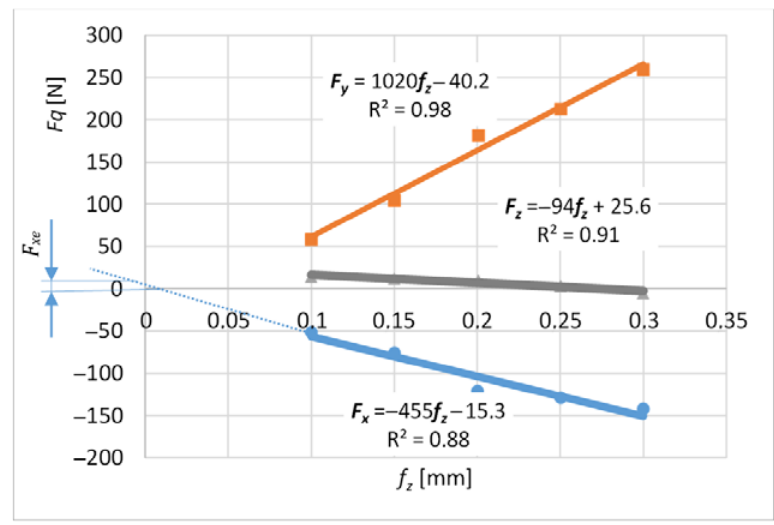
Figure 9. Graph of the average cutting forces for slot-milling.